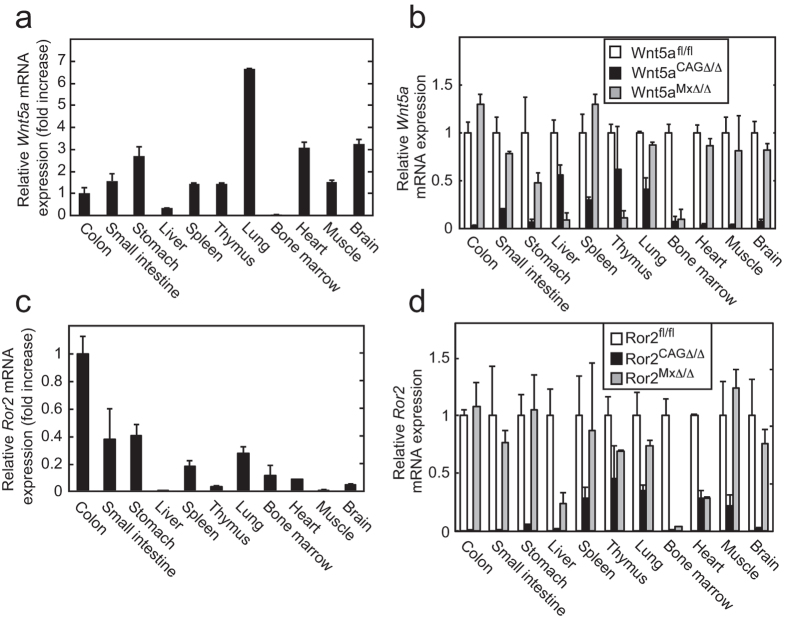
The Wnt5a and Ror2 mRNA levels in various tissues.(a) The Wnt5a mRNA levels in various organs isolated from control Wnt5afl/fl mice (n = 3) were measured using quantitative RT-PCR. Expression level of each tissue was normalized to that of colon. (b) The Wnt5a mRNA levels in the indicated organs isolated from Wnt5aCAGΔ/Δ (n = 3) and Wnt5aMxΔ/Δ mice (n = 3) were expressed compared with expression levels from Wnt5afl/fl mice (n = 3). (c) The Ror2 mRNA levels in various organs isolated from control Ror2fl/fl mice (n = 3). Expression level of each tissue was normalized to that of colon. (d) The Ror2 mRNA levels in the indicated organs isolated from Ror2CAGΔ/Δ (n = 3) and Ror2MxΔ/Δ (n = 5) mice were expressed compared with expression levels from Ror2fl/fl mice (n = 3). The results are shown as means ± SE.